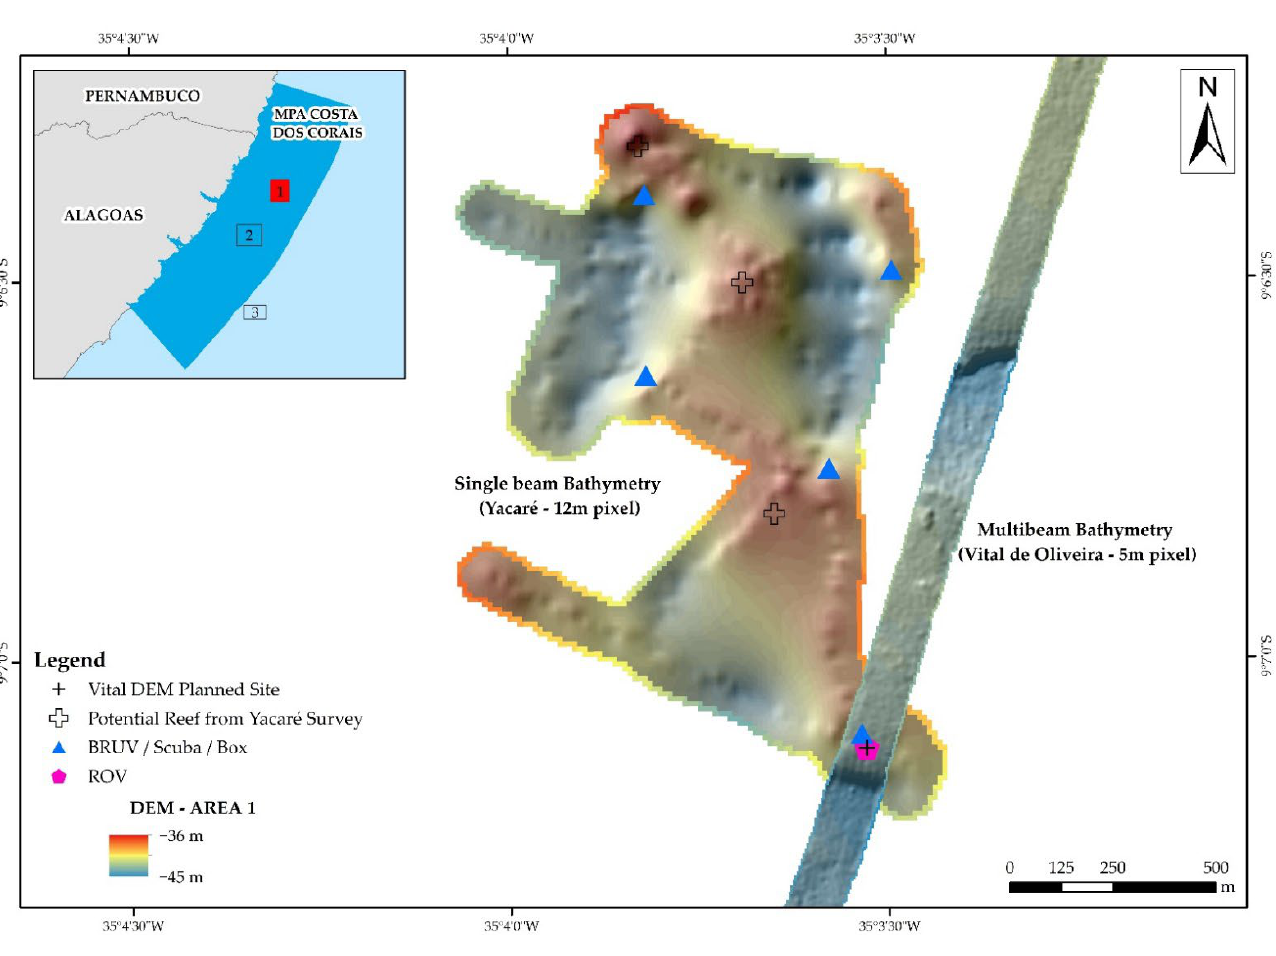
Figure 3. Digital elevation model (DEM) for area 1 with hillshade interpretation highlighting several features, such as the reef top, channels, and isolated head or pinnacle. Red square represents area 1.